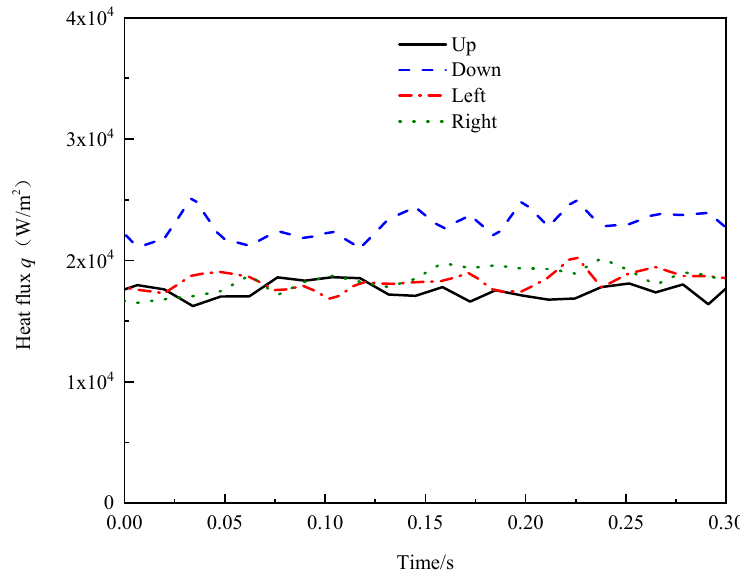
Figure 11. The heat flux at four typical position of the 0.2 mm wire heater during film boiling.